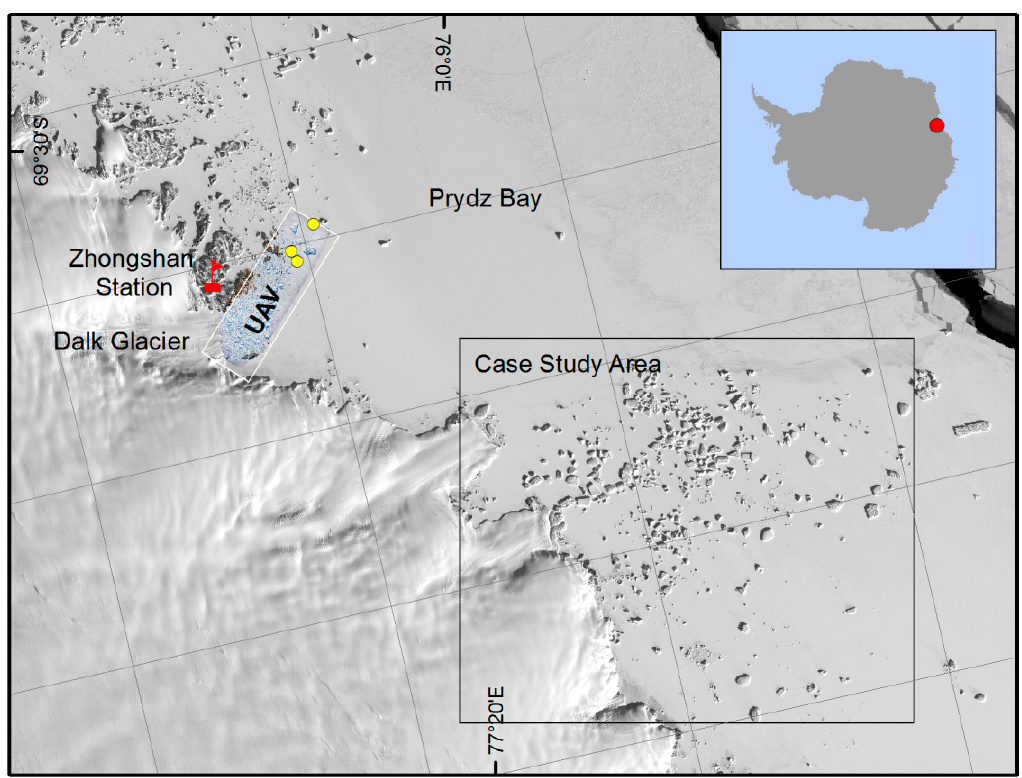
Figure 1. Locations of the case study area (black box) and the Unmanned Aerial Vehicle (UAV) data area (white box) overlaid on the Landsat-8 panchromatic image on 30 September 2016. The yellow points are the locations of the three UAV icebergs used in the validation.